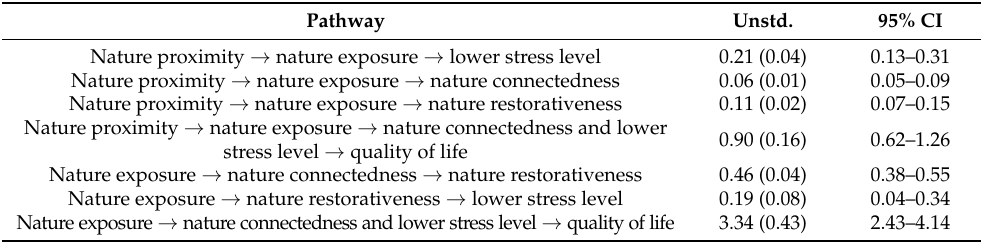
Table 4. Indirect effects with standard error (SE) and 95% confidence intervals in the final path model.